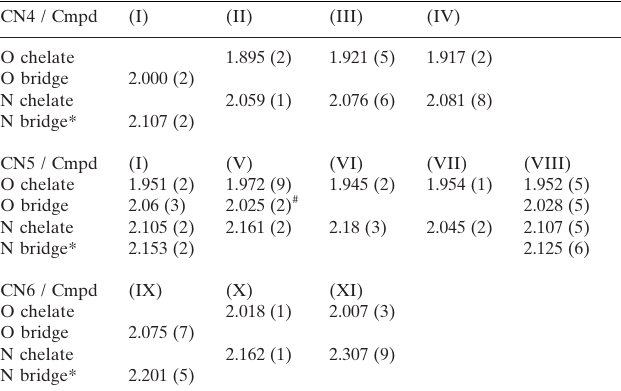
Notes: compound (I) corresponds to the title compound and (II)–(XI) are defined in the supplementary material. (*) The ‘N bridge’ indicates a ketiminate N atom for ligands where the O donor is doubly-bridged between two Mg atoms. (#) Terminal rather than bridging ketiminate O